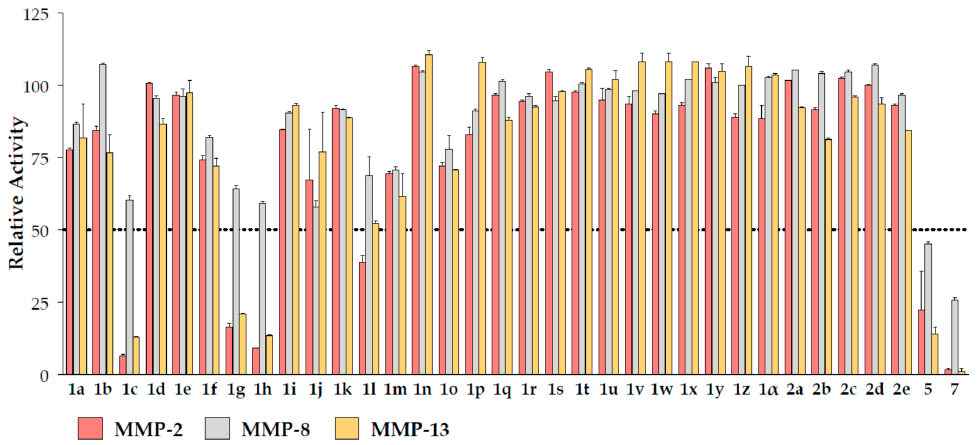
Figure 4. Residual enzyme activity on MMP-2, MMP-8 and MMP-13 of Compounds 1a – α , 2a – e , 5 and 7 at 100 µM. Table 4. Activity data (IC 50 , µM) on MMP-2, MMP-8 and MMP-13.